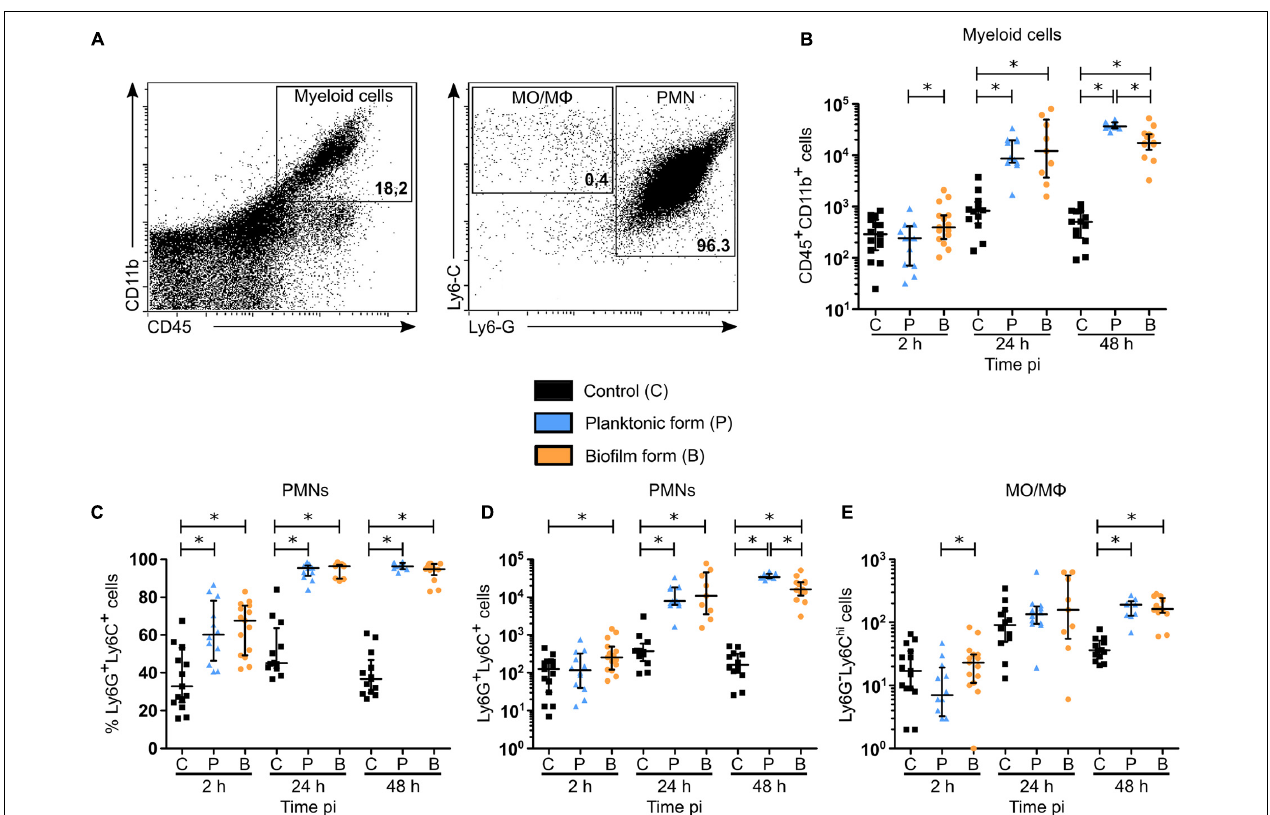
FIGURE 4 | Myeloid cell recruitment in the skin of S. aureus infected tissue. (A) Flow cytometric analysis showing the gating strategy of myeloid cells (CD45 + CD11b + , left plot—upper right region), PMNs (Ly6G + Ly6C + , right plot—right most region), MOs/M (cid:56) s (Ly6G - Ly6C hi , right plot—upper left). Representative dot plots and percentages of cells gated are shown from planktonic infected WT C57BL/6J mice at 48 h pi. (B) Total number of myeloid cells among live cells in ear pinna tissue of control and planktonic or biofilm infected mice from 2 h pi to day 2 pi (median ± IQR, number of mice: N C = 12–15, N P = 9–12, N BF = 9–15, from at least 3 different experiments, Mann-Whitney two-tailed test, ∗ p < 0.05). (C–E) Percentages (C) and total numbers (D,E) of PMNs (C,D) and MOs/M (cid:56) s (E) among myeloid cells in ear pinnae of control and planktonic or biofilm infected mice, from 2 h pi to day 2 pi (median ± IQR, number of mice: N C = 12–15, N P = 9–12, N BF = 9–15, from at least 3 different experiments, Mann-Whitney two-tailed test, ∗ p <